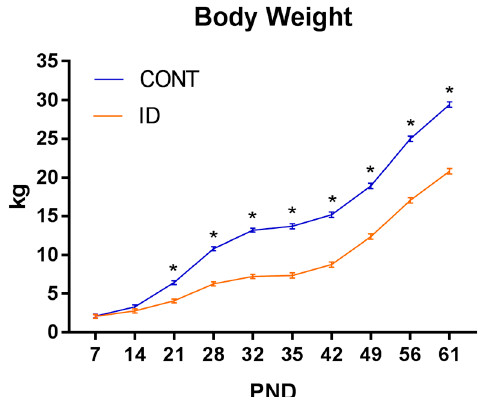
Figure 2. Effect of early-life iron status on pig body weight. Early-life dietary iron status has long-lasting influences on pig body weight for a time longer than the period spent in an ID state. Interactive effects of diet and PND were observed ( p < 0.001), and SEM error bars are present. Abbreviations: CONT, control; ID, iron deficient; PND, postnatal day; SEM, standard error of the mean.